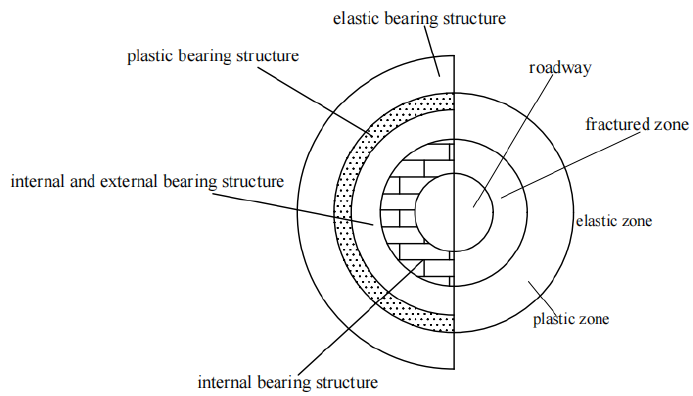
Figure 12. A schematic diagram of the inner and outer bearing structures of the surrounding rock.